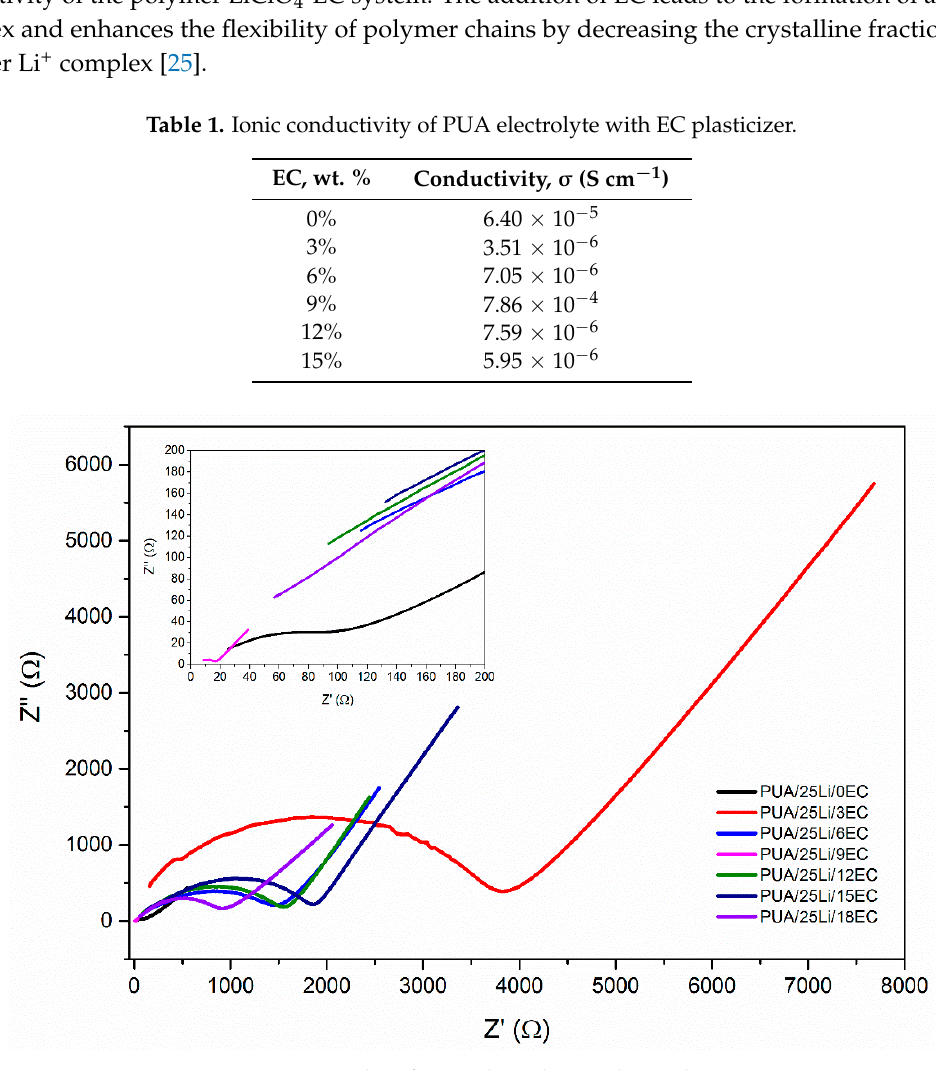
Figure 2. Nyquist plot of PUA electrolyte with EC plasticizer.